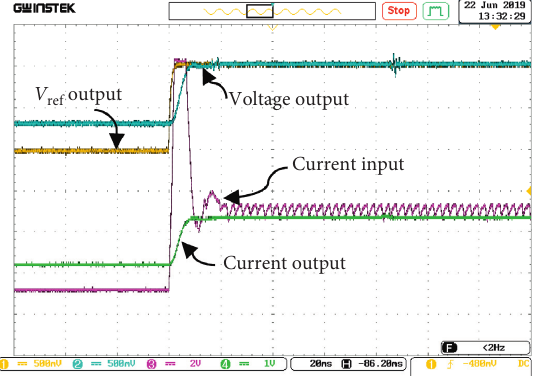
Figure 29: Result of maintaining voltage stability and current while changing load using a PI controller with TS search.